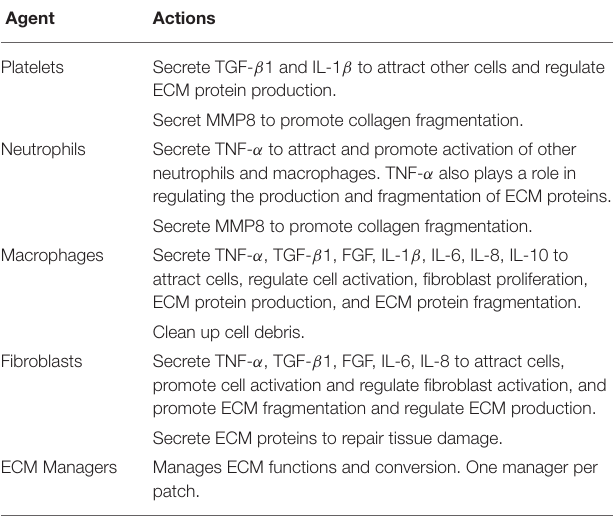
TABLE 1 | Summary of agent rules.